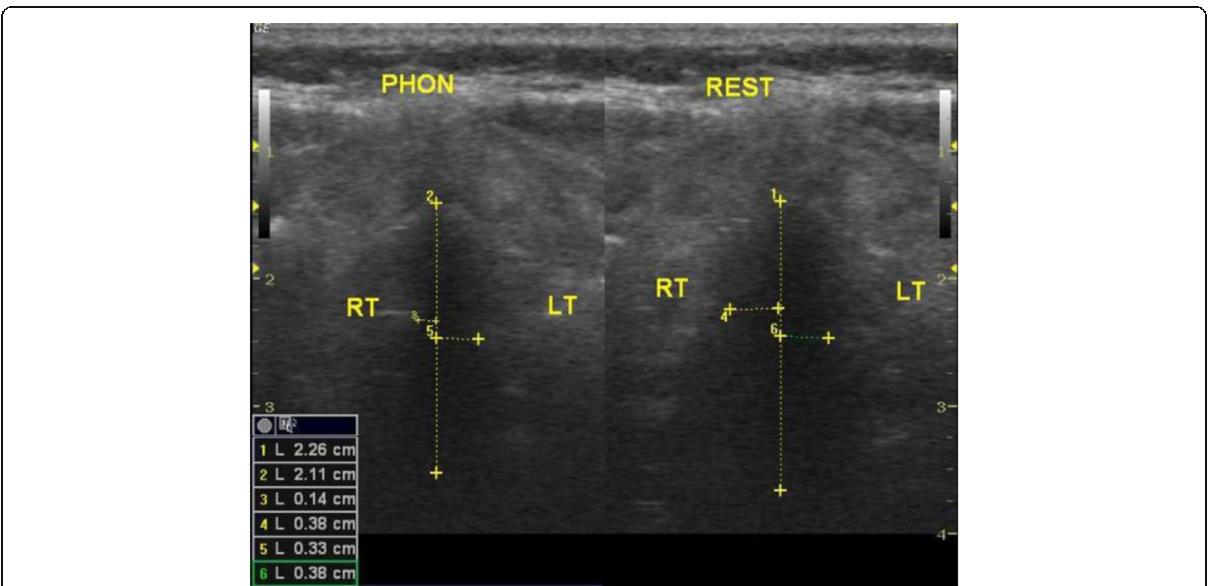
Fig. 3 An ultrasound photo assessing vocal cord mobility in a patient with VC paralysis (abducted type) by drawing imaginary perpendicular line from the junction between both thyroid cartilage anteriorly where distance 3 (0.14 mm) and 4 (0.38) represent contribution of the right VC in respiratory chink in both respiration and phonation. Where distance 5 (0.33 mm) and 6 (0.38 mm) represent contribution of the right VC in respiratory chink in both respiration and phonation